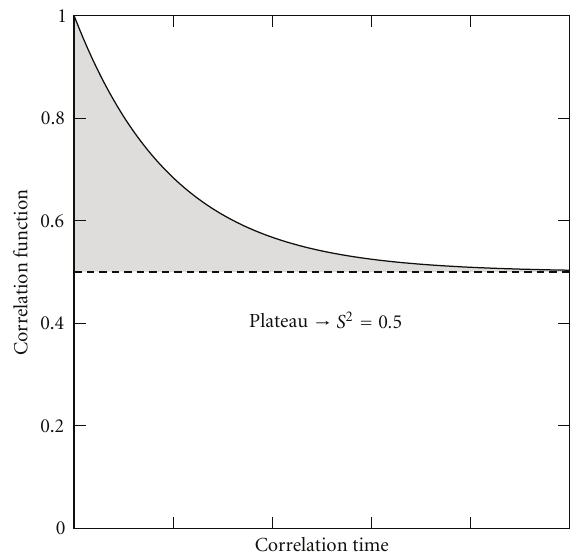
Figure 2: Internal autocorrelation function for an imaginary bond vector where S 2 = 0 . 5, the plateau value as the function converges towards infinity. The area between the curve and S 2 is the local correlation time ( τ